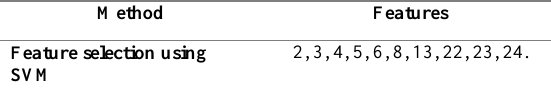
Table 2. Selected features by Feature selection using SVM method.